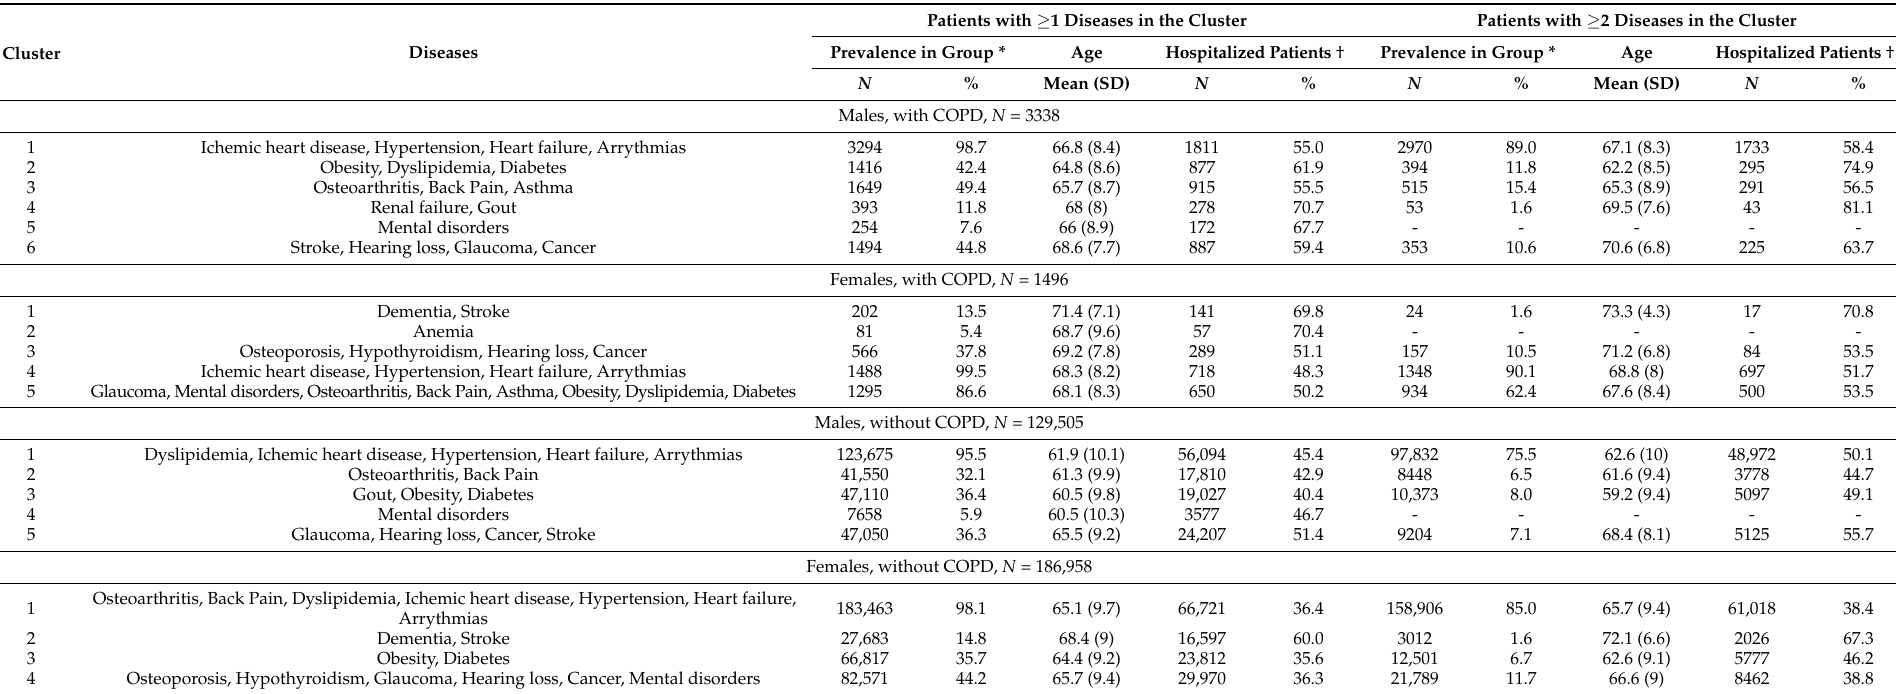
Table 4. Clusters by gender and COPD